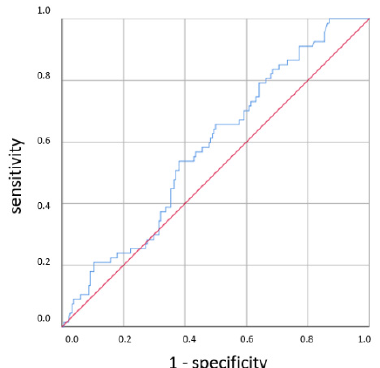
Figure 7. CRP concentration at the time of sepsis workup. Culture-positive LOS.